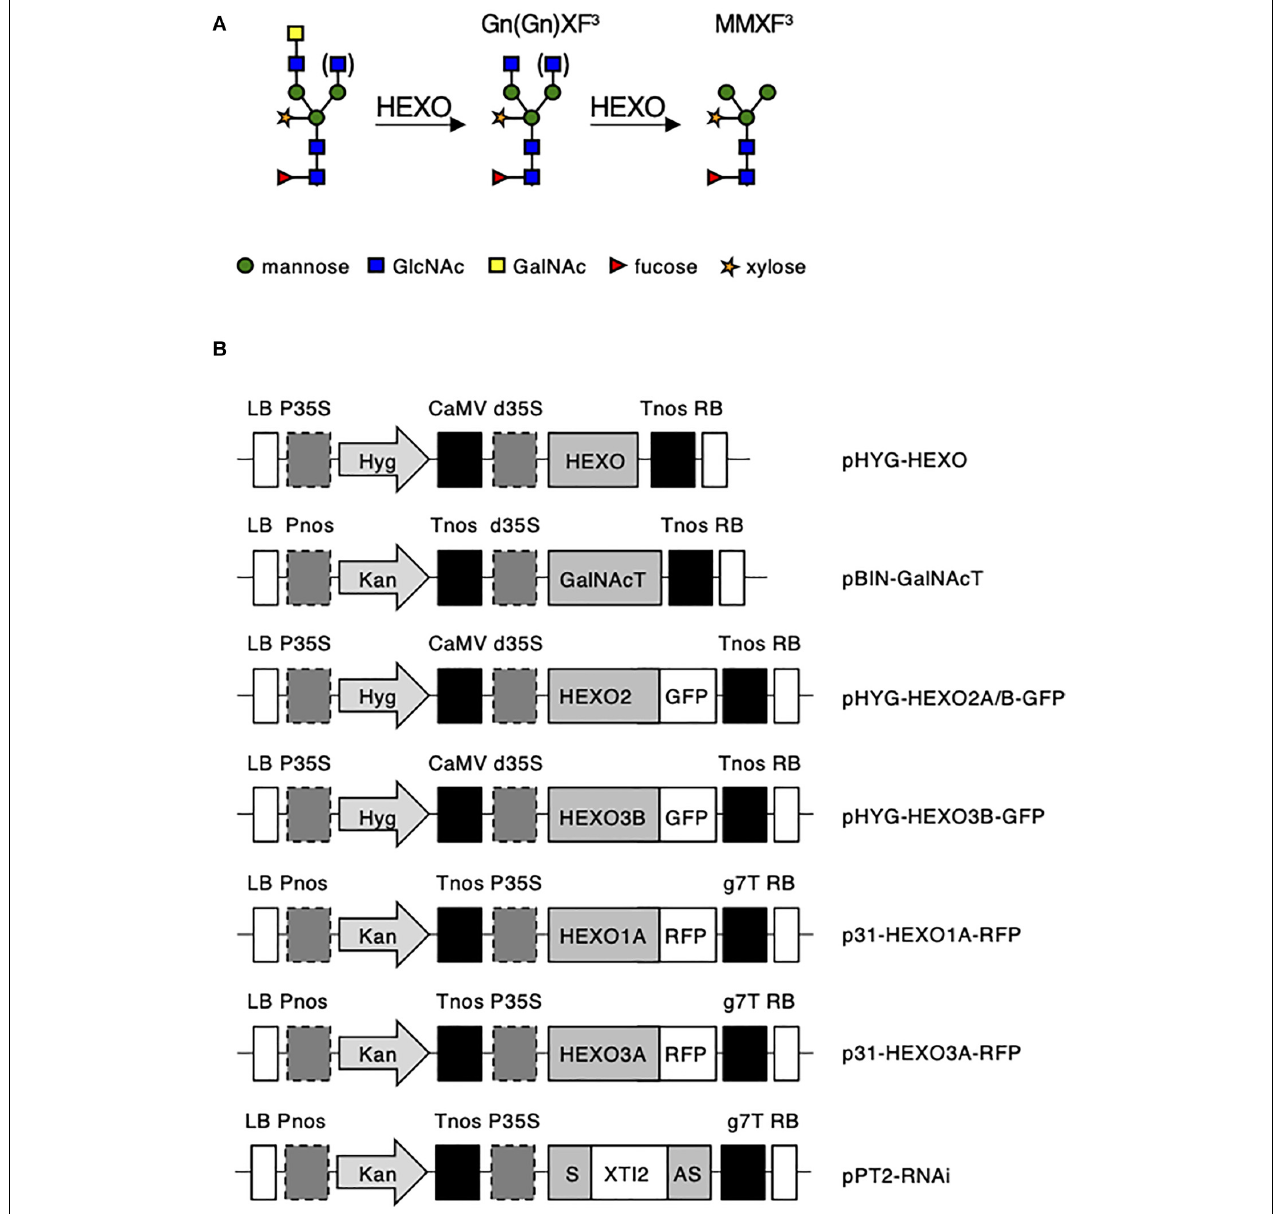
FIGURE 1 | (A) Schematic illustration of proposed plant HEXO activity on complex LDN-carrying N-glycans. (B) Schematic overview of the expression vectors used in this study. LB, left border; Pnos, nopaline synthase gene promoter; Hyg, hygromycin B phosphotransferase gene; Kan, neomycin phosphotransferase 2 gene; Tnos, nopaline synthase gene terminator; CaMV, cauliflower mosaic virus; d35S, dual cauliflower mosaic virus 35S gene promoter; P35S, cauliflower mosaic virus 35S gene promoter; HEXO, N. benthamiana HEXO ORF; GalNAcT, β 1,4- N -acetyl-galactosaminyltransferase from Caenorhabditis elegans; GFP, green fluorescent protein; RFP, red fluorescent protein; XYLT, Arabidopsis thaliana b1,2-xylosyltransferase ORF; S: HEXO RNAi sequence in sense orientation; XTI2, intron 2 from A. thaliana XYLT; AS, HEXO RNAi sequence in antisense orientation; g7T, Agrobacterium gene 7 terminator; and RB, right border.